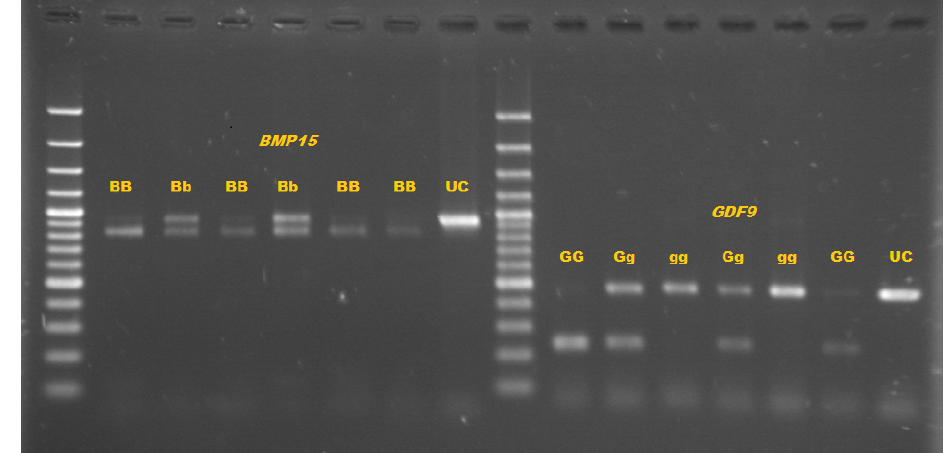
Figure 3. Genotypes of BMP15 gene, BB (757bp/100bp), and Bb (857bp/757bp/100bp) (UC − uncut). Genotypes of GDF9 gene, GG (234bp/229bp), Gg (463bp/234bp/229bp), and gg (463bp).